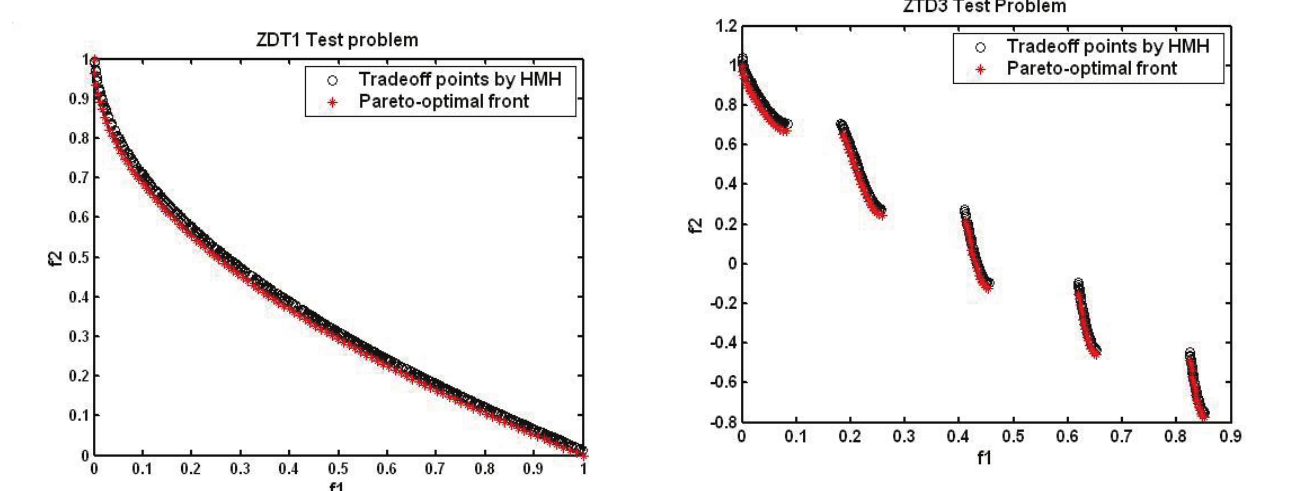
Fig. 6. Tradeoff points with HMH technique on